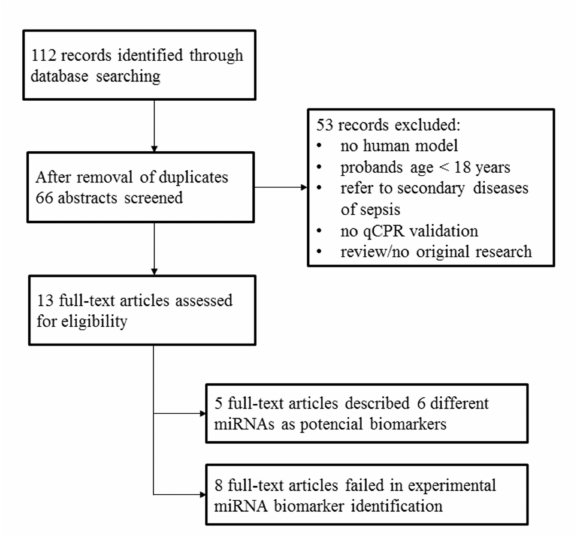
Figure 3. Literature research was performed on 1 March 2018 utilizing the databases PubMed / MEDLINE and Web of Science by means of the search terms “sepsis”, “miRNA*”, “biomarker*” combined with the Boolean operator “AND”.